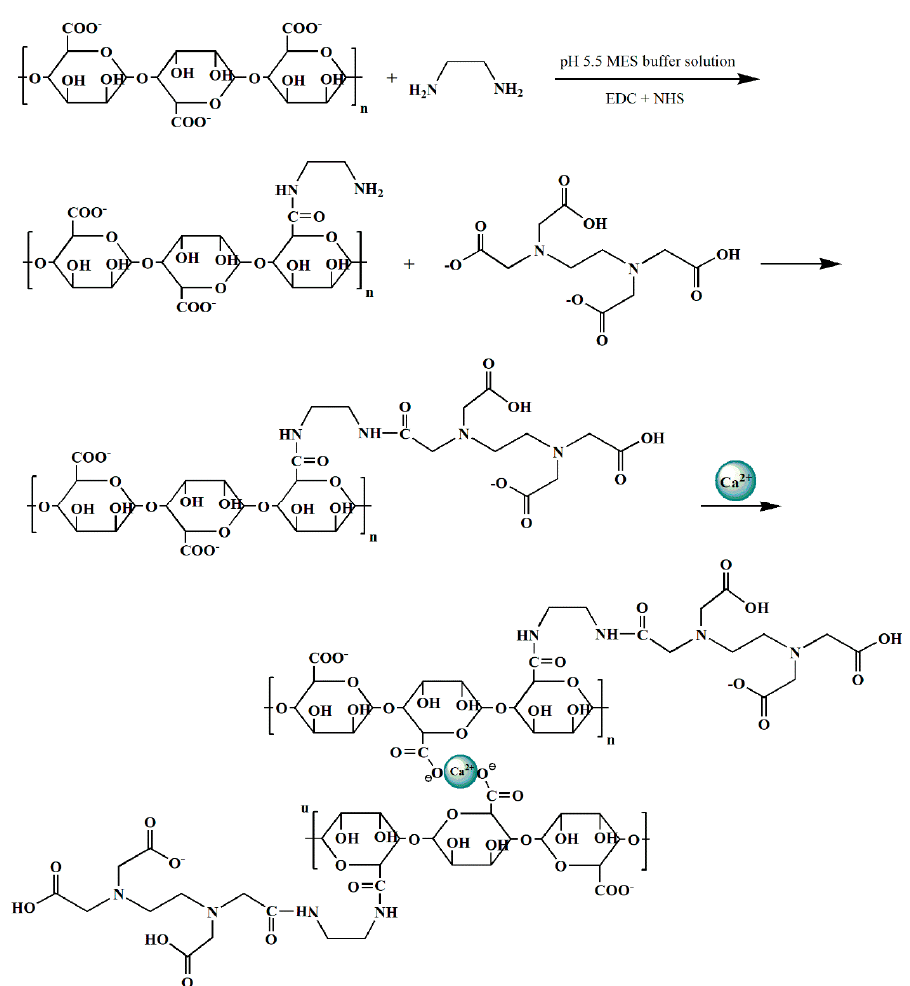
Figure 1. Synthesis route of the calcium alginate-disodium ethylenediaminetetraacetate dihydrate hybrid aerogel (Alg-EDTA).